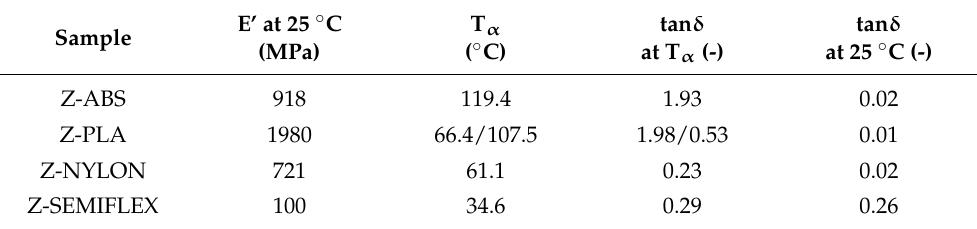
Figure 5. Representative stress–strain curves of Z-ABS, Z-PLA, Z-NYLON and Z-SEMIFLEX ( a ), together with an enlarged view of the small elongation range ( b ).